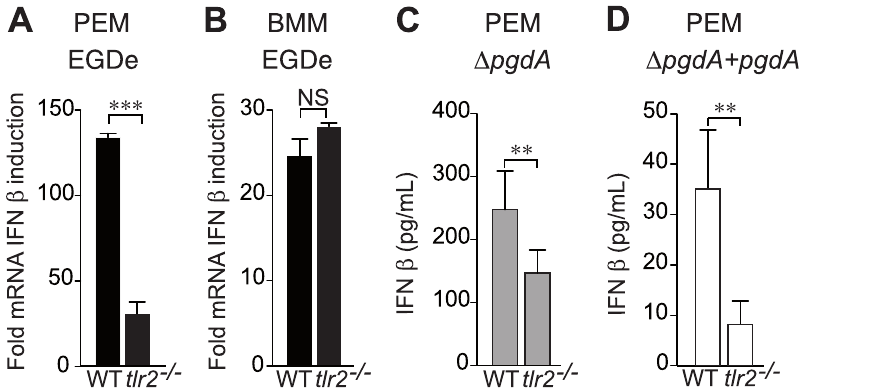
Figure 2. TLR2 is required for PgdA-mediated IFN- b response to Listeria in peritoneal but not bone-marrow macrophages. (A) PEM from C57BL/6J or tlr2 2 / 2 mice were infected with the parental EGDe strain. After 4 h of infection, IFN- b induction was measured by qRT-PCR. (B) BMM from C57BL/6J or tlr2 2 / 2 mice were infected with the parental EGDe strain. After 4 h of infection, IFN- b induction was measured by qRT-PCR. Data are mean 6 SD (NS, non significant; ***, p , 0.0001, n =3). PEM from WT C57BL/6J or tlr2 2 / 2 mice were infected with the D pgdA mutant (C) or the complemented D pgdA strain (D). After 7 h of infection, IFN- b levels were measured in supernatants by ELISA. Data are mean 6 SD (**, p , 0.01, n =5).